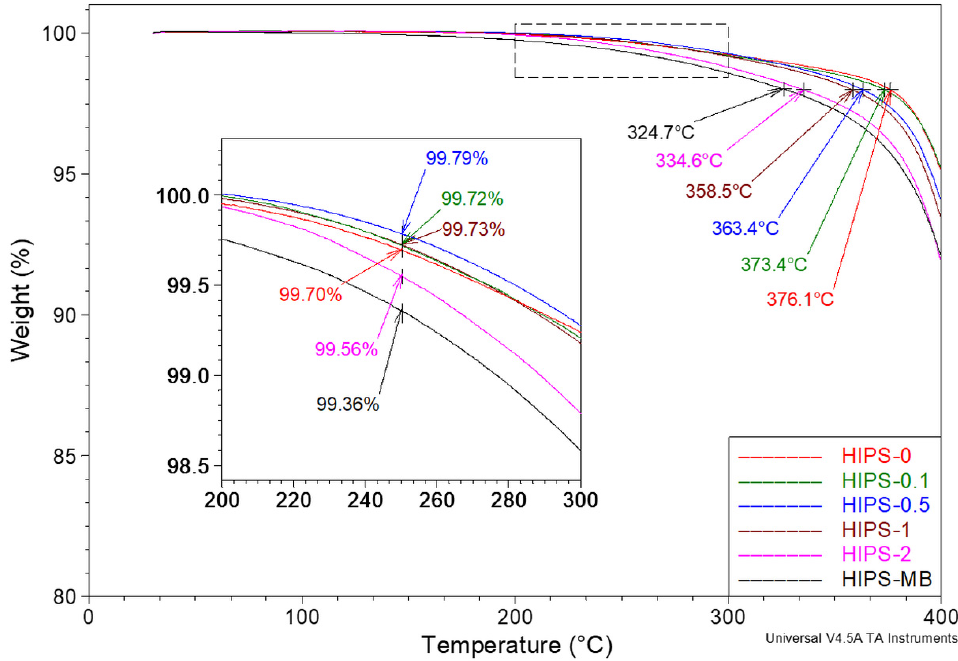
Figure 9. Summary of TG curves for a series of HIPS filaments registered at heating rate of 20 °C/min. Measurements ranging from 30 to 400 °C under nitrogen atmosphere. Purge flow 60 mL/min. The figure shows the 2% mass loss temperature and the analysis of the thermal stability of the samples at 250 °C (insert view).